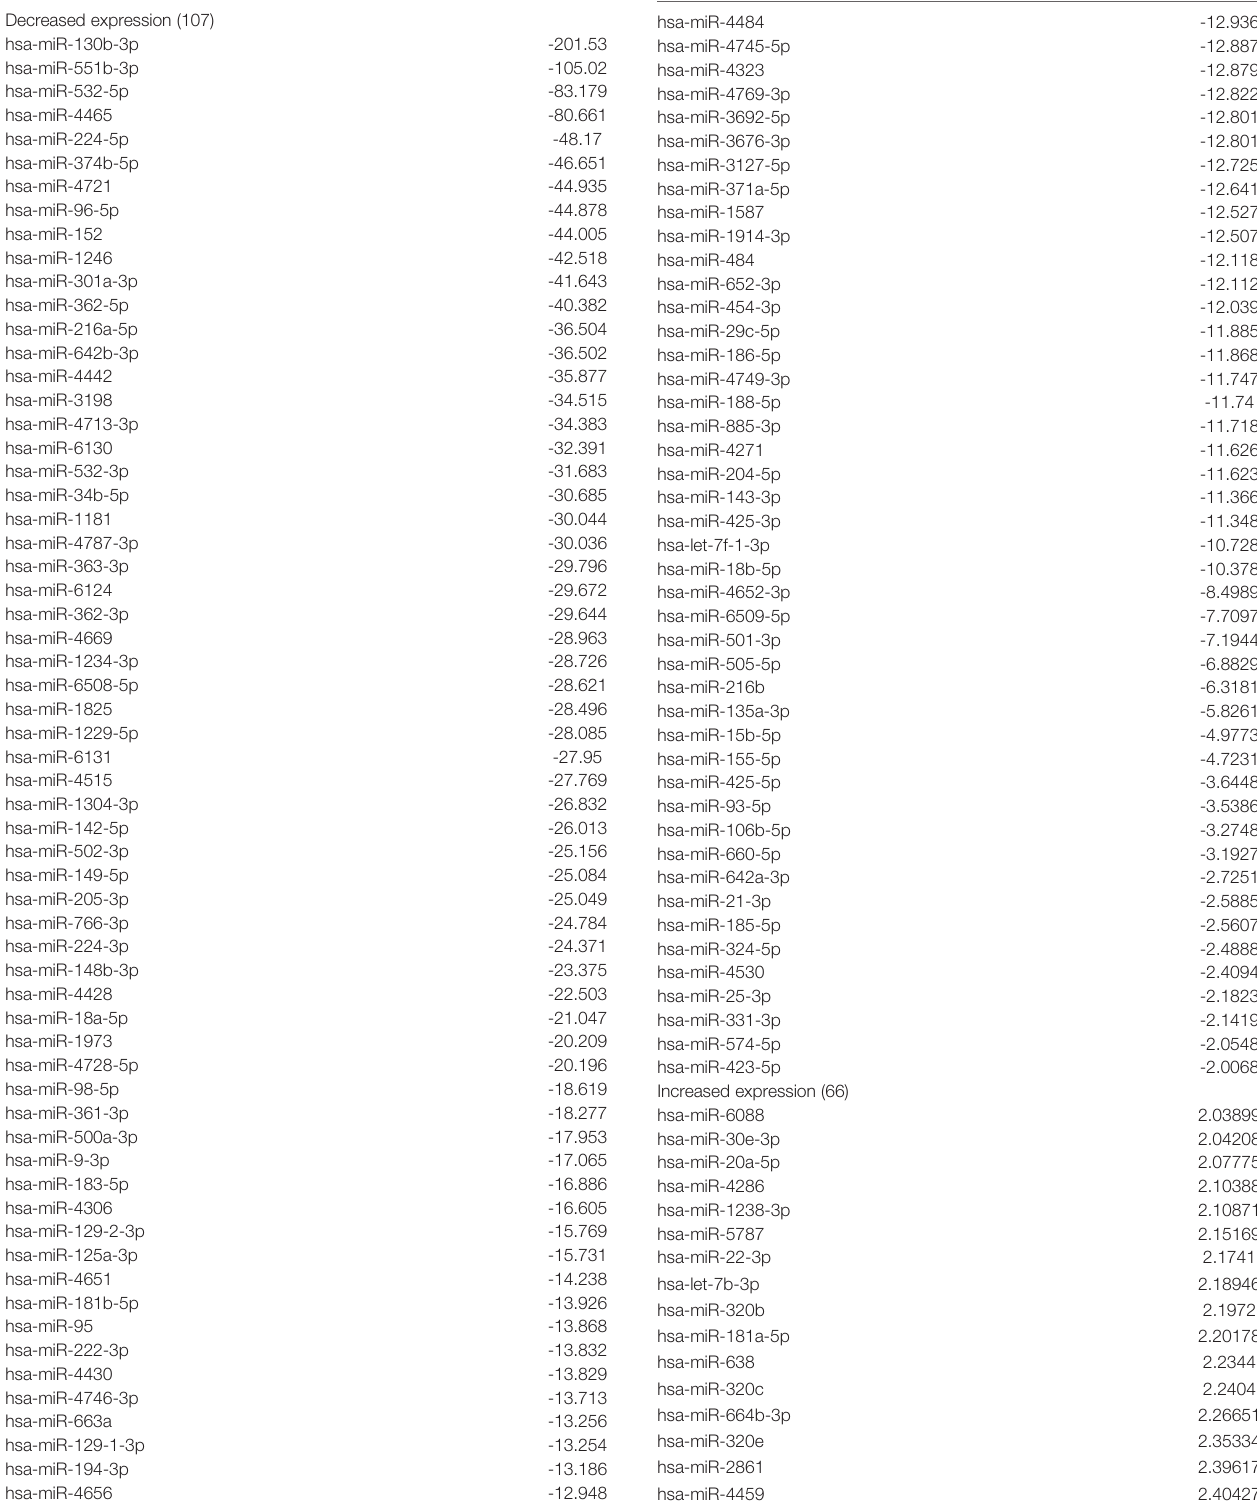
TABLE 5 | Dysregulation of miRNAs in hepatocellular carcinoma tissue. miRNA